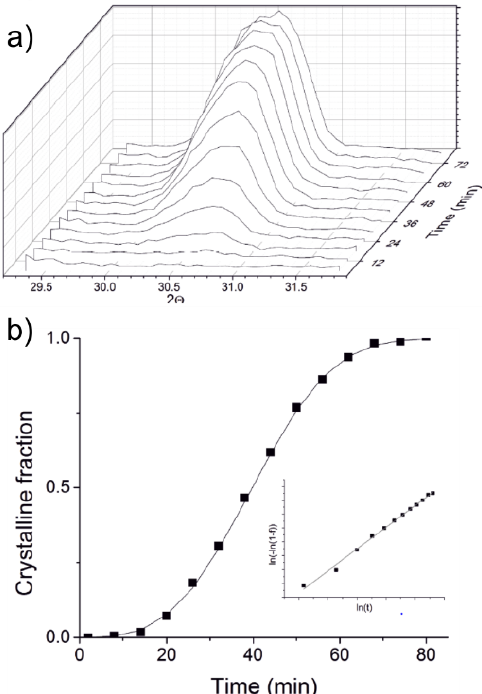
Fig. 1. Time evolution of the cubic HfO 2 111 peak of the 50 nm thick layer during the 550°C annealing a) as well as the relating fitted peak integral as a function of annealing time b). The inset shows the curve in logarithmic scale.